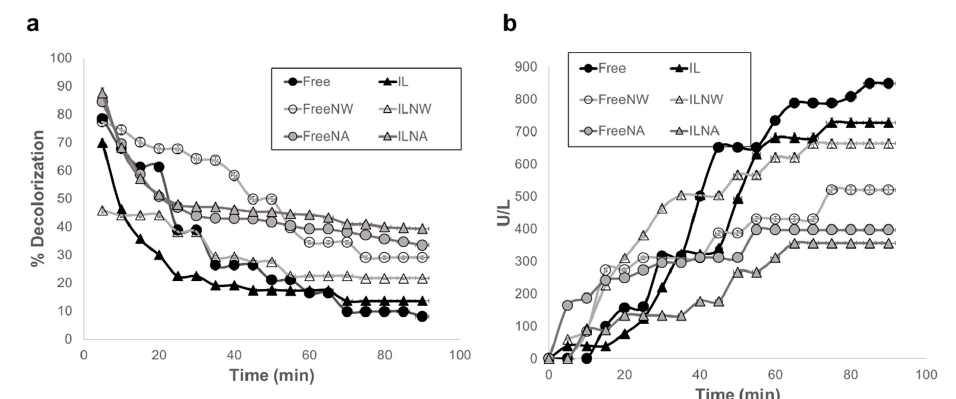
Figure 6. Decolorization and residual activity measurements of Free, IL, FreeNW, ILNW, FreeNA, and ILNA. ( a ) Percentage of decolorization as a function of time and ( b ) cumulative enzymatic activity (U L − 1 ) of the artificial wastewater after the decolorization treatment. NW = silanized SiO 2